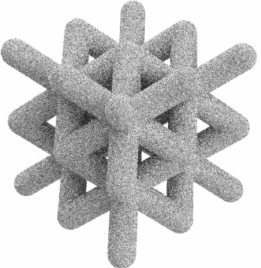
Figure 1. Partial schematic diagram of the star type lattice structure.